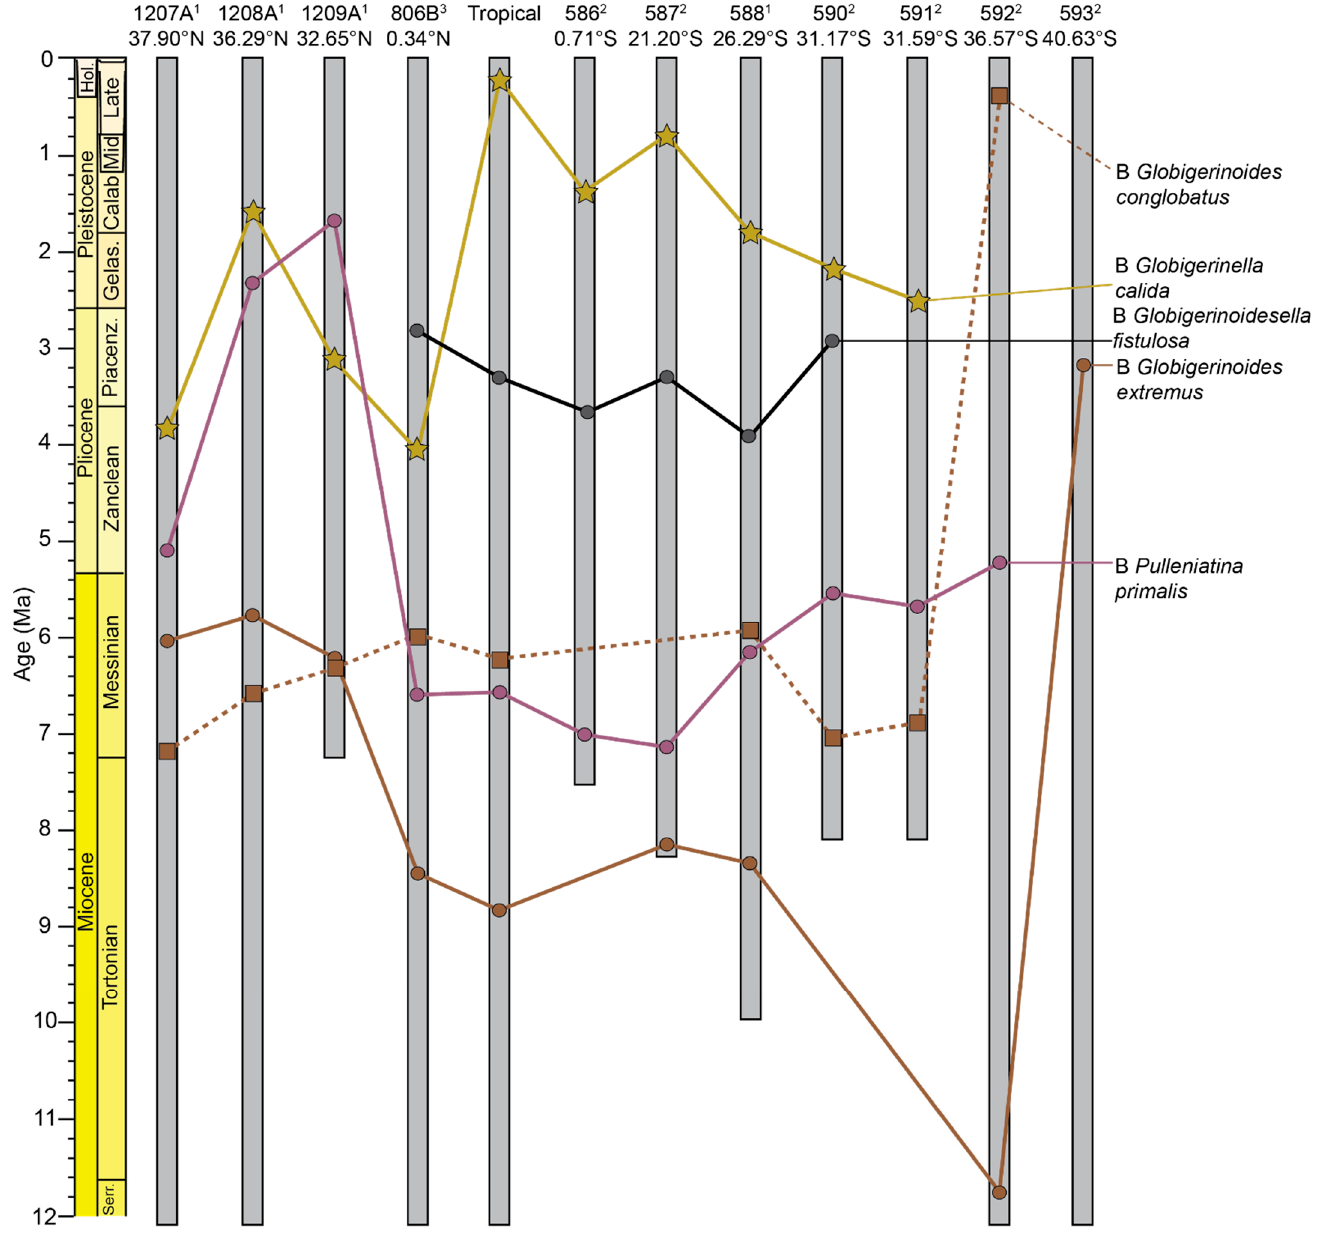
Figure 3. First occurrences of species used as primary and secondary datums in tropical-to-mid- latitude biostratigraphic zonations belonging to the genera Globigerinoides , Globigerinella , Globigeri- noidesella , and Pulleniatina . Sites are ranked 1–3, as denoted by the superscript number beside each site number. A ranking of 1 indicates that the sites’ age model is based solely on magnetostratigraphy, a ranking of 2 indicates that the sites’ age model is a mix of magnetostratigraphy and biostratig- raphy, and a ranking of 3 indicates that the sites’ age model is based solely on biostratigraphy (Supplementary Table